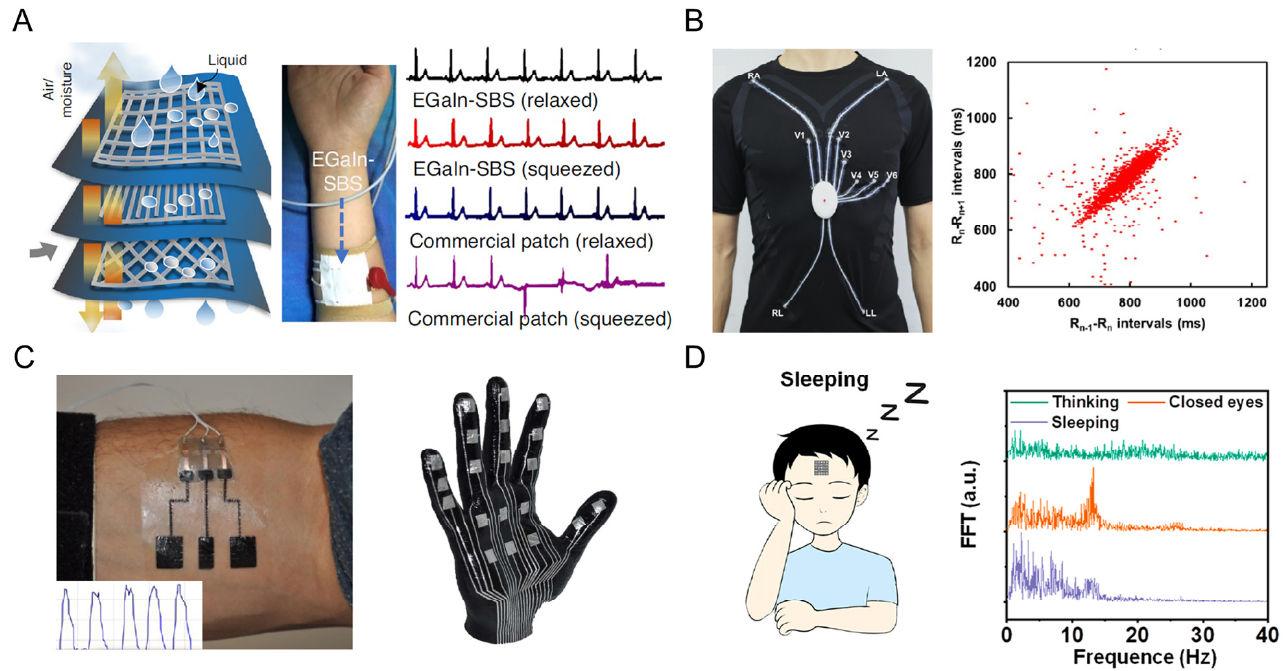
Figure 9. The LM-based electrode for real-time physiological signal collection. ( A ) Schematic illus- tration of LM-based monolithic stretchable electronics in which the top layer is the electrode for ECG monitoring [57]. Copyright: (2021) Springer Nature. ( B ) Image of LM-based 12-lead ECG mon- itoring system on a knitted T-shirt ( left ) and the Lorenz plot of ECG under the sleeping condition of the volunteer [100]. Copyright: (2022) American Chemical Society. ( C ) The LM electronic tattoo for EMG signal acquisition on a forearm ( left ) and capacitive sensor mesh on a 3D hand model. Copyright: (2018) American Chemical Society [98]. ( D ) Schematic diagram of the real-time EEG re- cording in the mental state of sleeping, and the frequency distribution of EEG with fast Fourier transform [99]. Copyright: (2022) American Chemical Society. 4.2. Interconnectors for Functional Circuits Serving as stretchable circuits and connectors, LM composites exhibit exceptional electrical robustness and high conductivity upon on-skin deformation, making them a po- tential candidate for a wearable biosensor. Skin-attachable biosensors are of significance for healthcare monitoring and disease diagnoses such as diabetes and rehabilitation [101]. Carbon nanotubes (CNTs) can form an electrostatic interaction with LM particles with the help of negatively charged polyelectrolytes (poly(sodium4-styrene sulfonate) (PSS)) (Fig- ure 10A) [102]. Based on this, an intrinsic electrical conductivity was imposed for carbon nanotubes on LM particles (CMP) whilst coated on human skin. After functionalization with glucose oxidase, alcohol oxidase, and lactate oxidase, the CMP-based working elec- trode realized the measurement of glucose, ethanol, and lactate. Additionally, the respir- atory activity monitoring of humans plays a critical role in non-invasive medicine. An LM electrode can be applied to an epidermal respiration sensor for monitoring the level of relative humidity and the concentration of NO gas exhaled by humans (Figure 10B) [103]. Through this, different respiratory patterns were distinguished based on the water amount and potential lung diseases (e.g., asthma) can be diagnosed timely. Then, the LM-based circuit would facilitate multifunctional sensors when equipped with